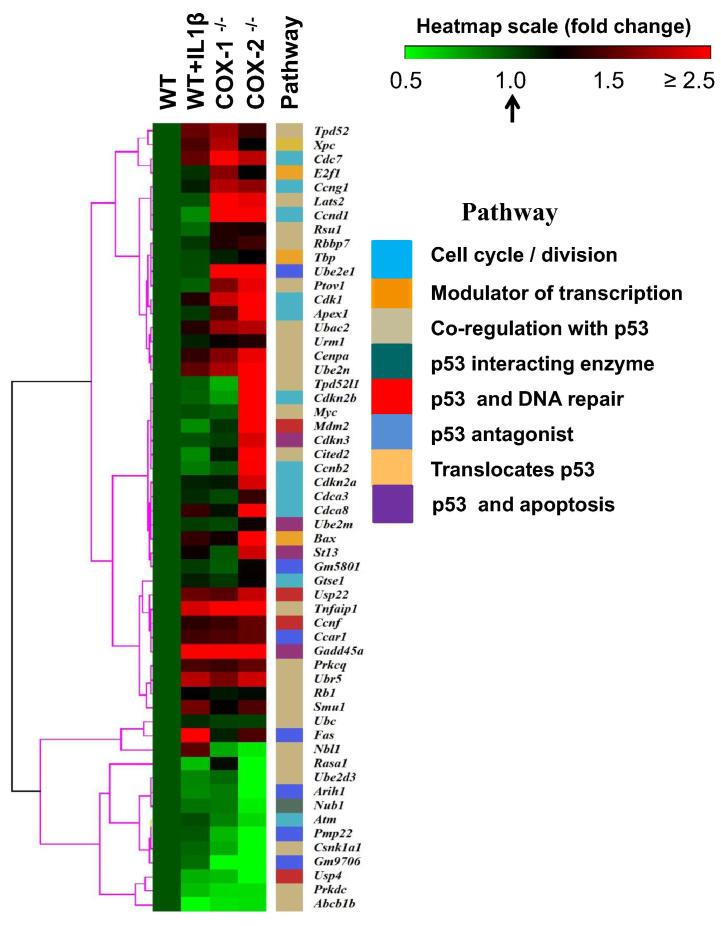
Gene expression of p53-related genes in COX-1 and COX-2 ablated cellsThe differential gene expression of p53-associated transcripts termed as p53-targets is presented as a heat map for WT, WT + IL-1β, COX-1−/−, and COX-2−/− cells. Fold change of expression is indicated in color gradient (color toward red indicates higher gene expression levels and color toward green indicates lower expression levels as compared to WT). The differentially expressed genes were grouped into distinct pathways, which are color-coded based on the direct or indirect interactions with p53. A detail list of these transcripts and the associated fold changes is shown in Table S1.